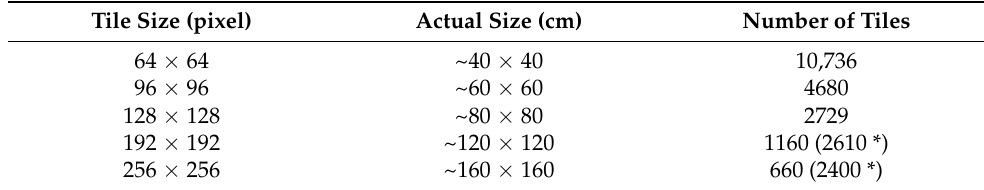
Table 2. Number of tiles generated from Top Pit orthomosaic for each image tile size. Tile Size (pixel) Actual Size (cm) Number of Tiles 64 × 64 ~40 × 40 10,736